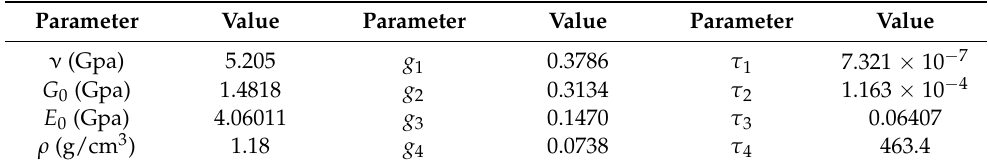
Table 2. Prony series parameters for epoxy